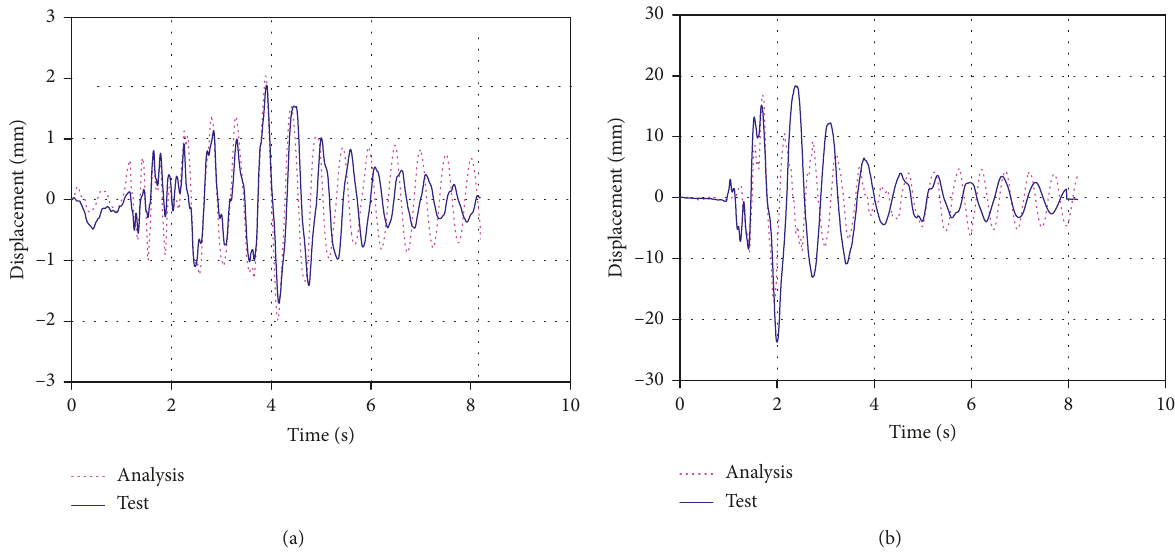
Figure 5: Comparison on the time-history response of the top displacement between test and FE analysis results. (a) Frequent earthquake (PGA � 140gal). (b) Rare earthquake (PGA � 880